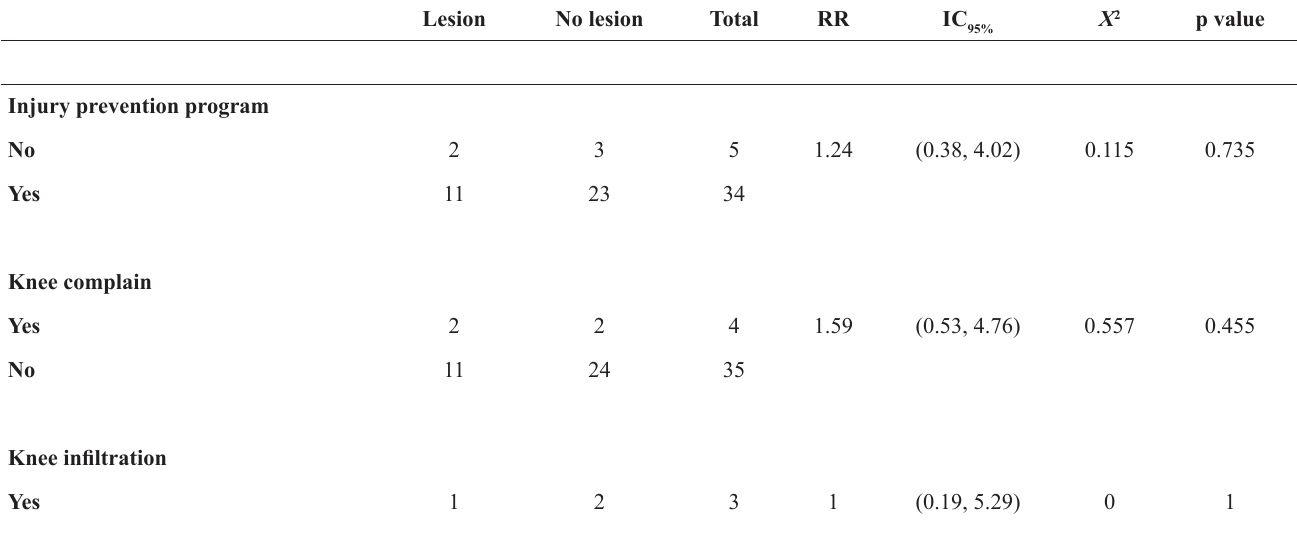
Table 4. Statistical evaluation of the association between each variable and the outcome. Sergipe, Brazil, 2014. Lesion No lesion Total RR IC